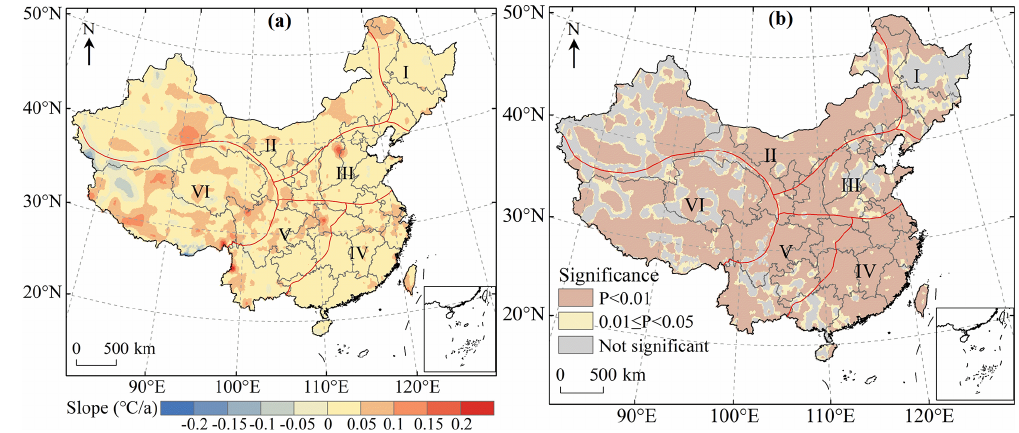
Figure 10. Inter-annual change rate of T max (a) and results of Mann–Kendall trend test (b) . Table 3. Statistics of T max change trends in various regions of China from 1979 to 2018. Region I II III IV V VI Whole Mean ( ◦ C per 10 years) 0.31 0.31 0.33 0.35 0.38 0.33 0.33 Significant upward (%) 65.21 69.45 87.03 92.29 87.00 67.93 75.13 Significant downward (%) 0.09 3.14 0 0.32 0.75 7.92